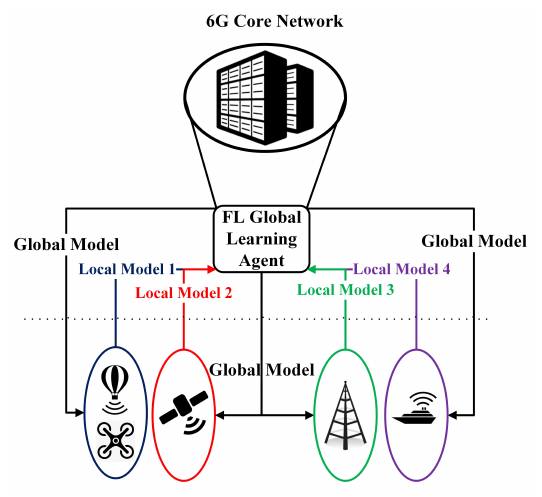
Figure 8. Potential FL-enabled 6G